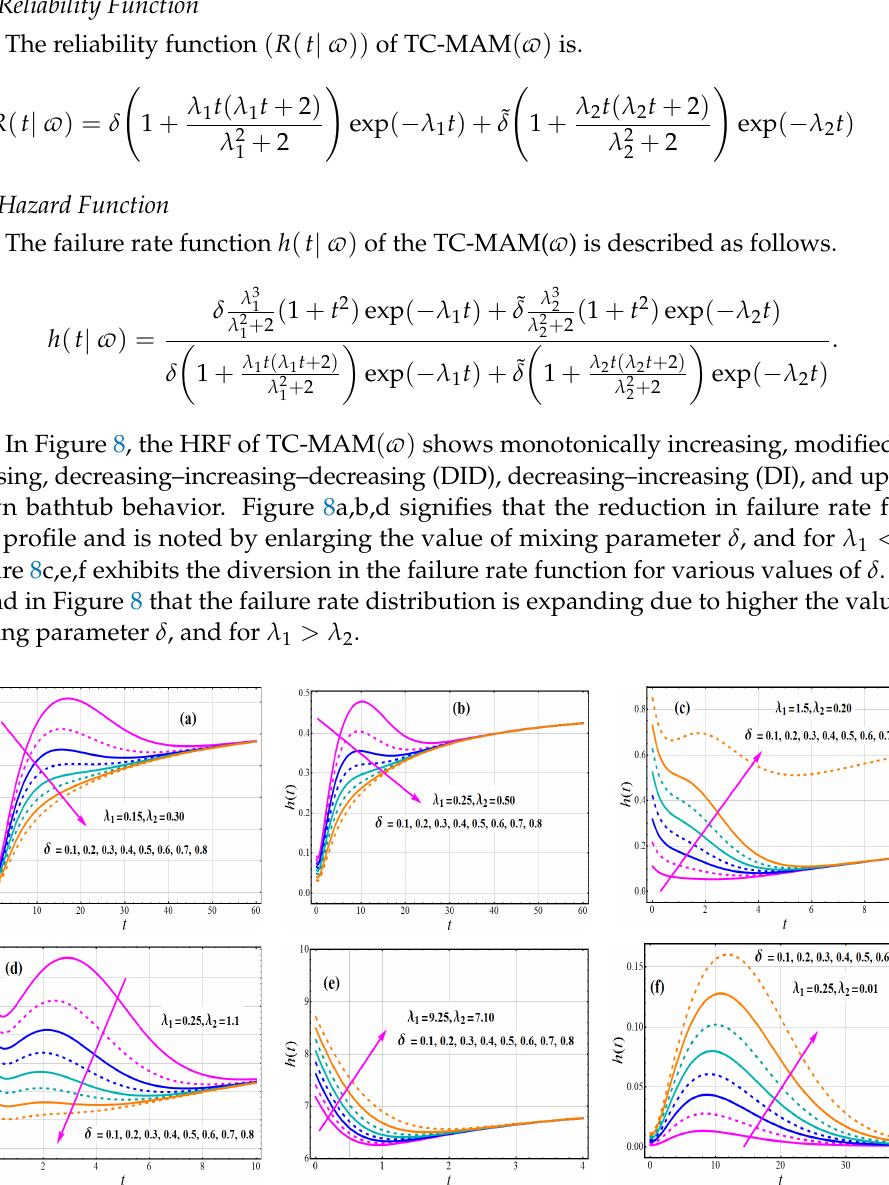
Fig. 8. Variations in h ( t Figure 8. Variations in h ( t | (cid:118) ) for λ 1 , λ 1 and δ